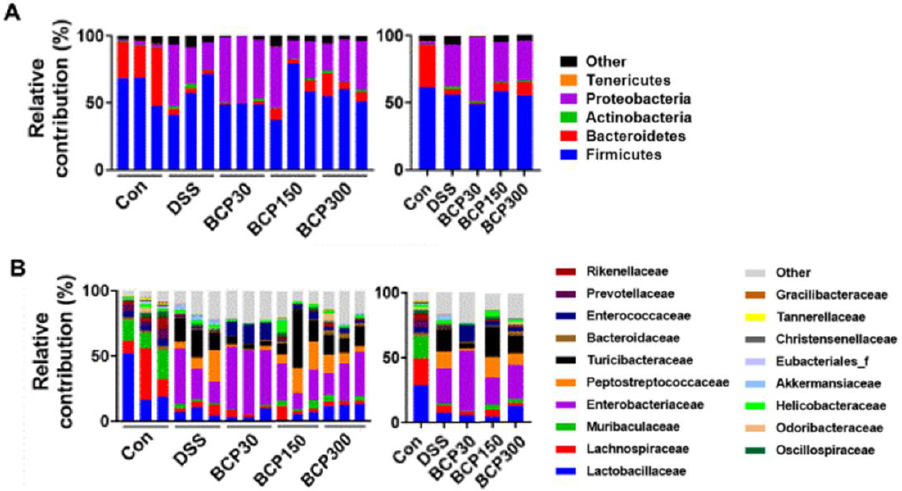
Figure 8. Taxonomic composition (percentage) of the gut microbiota of the experimental groups at the Phylum and Family levels. The gut microbiota were classified as ( A ) Phylum, and ( B ) Family.